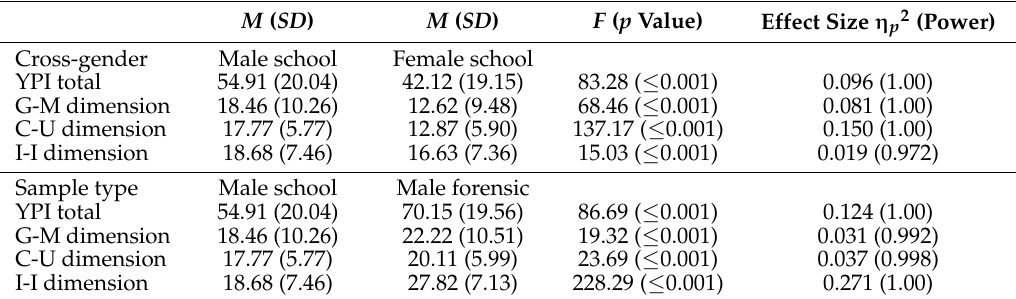
Table 6. Descriptive statistics and ANOVAs for the YPI and its